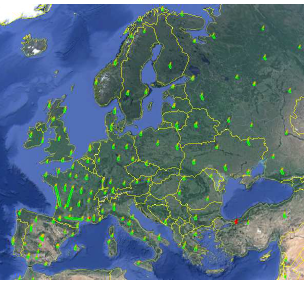
Figure 8 represents the validation level of confidence versus the number of GCP per products. As there is less references than for European block, more products cannot be validated (black ones) or with a less confident validation level (red ones). 29